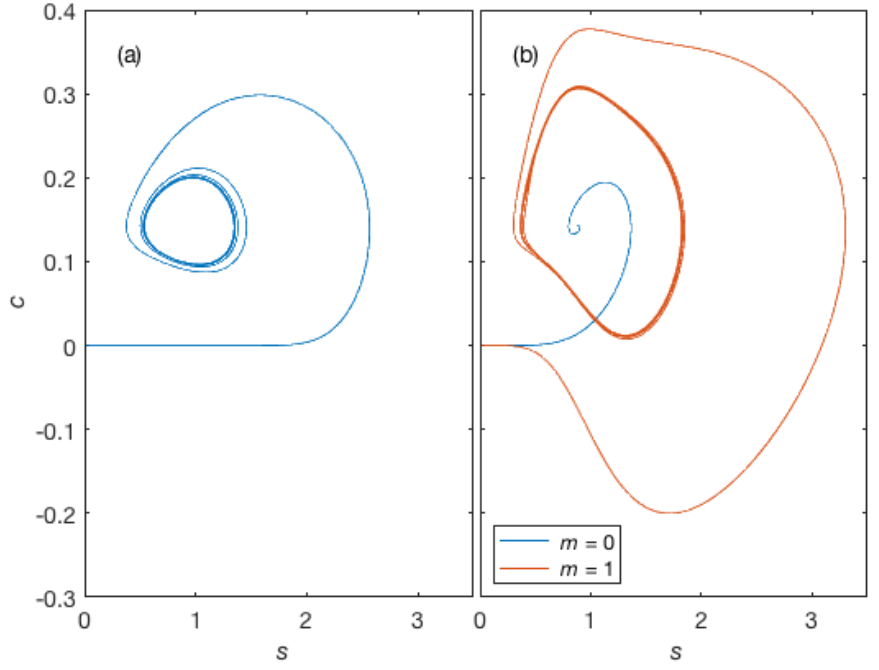
Figure 6. Trajectories of ( a ) the three-variable DDE model and of ( b ) the m = 0 and m = 1 reduced ODE models. The m = 1 model has an Andronov–Hopf bifurcation and can generate limit-cycle oscillations, like the three-variable model, whereas the m = 0 model never undergoes an Andronov–Hopf bifurcation. All parameters are as in Figure 4, except δ =